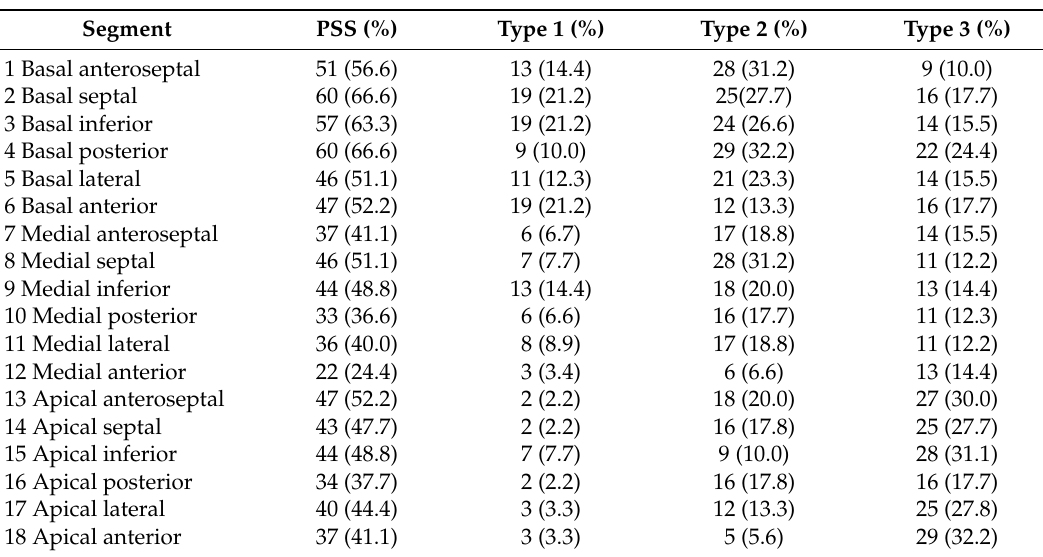
Table 3. PSS and its types according to segments of the LV (90 patients).